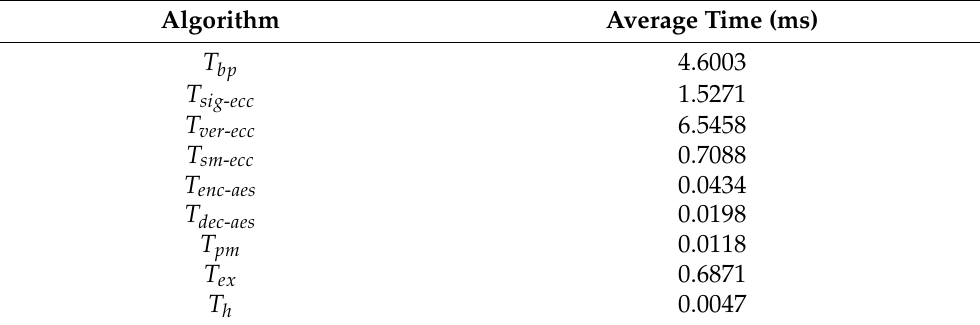
Table 4. The average time for each